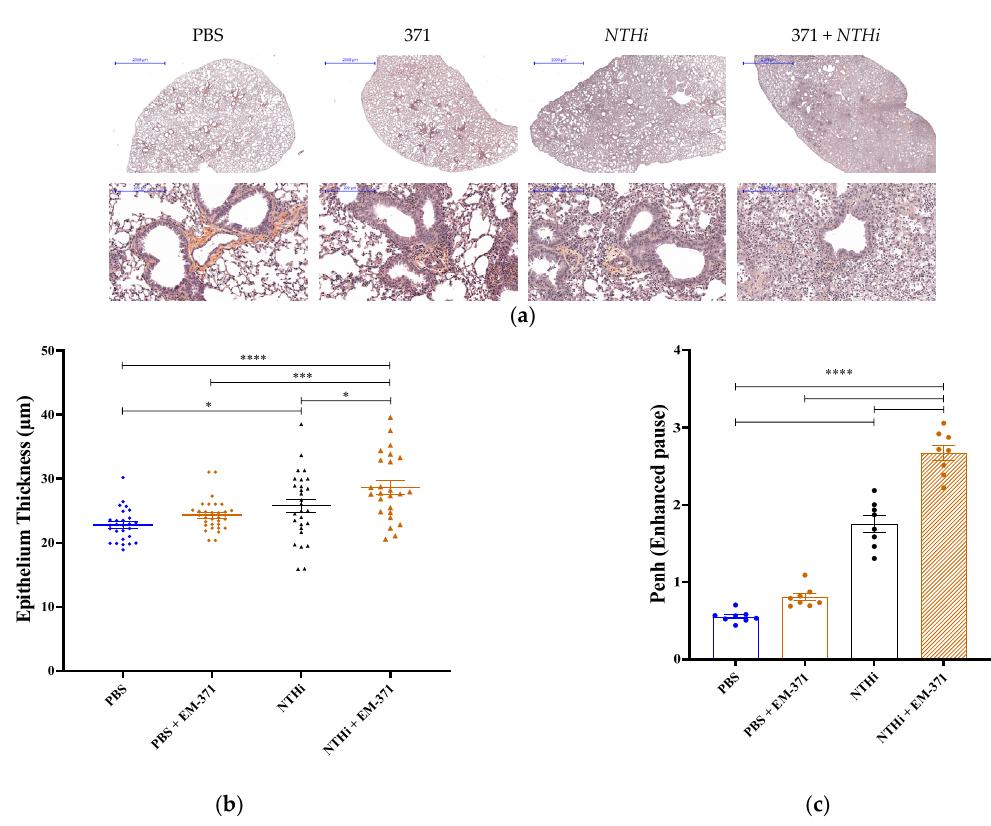
Figure 5. NTHi -challenged mice showed increased levels of inflammatory cell recruitment near the airway and epithelium thickening. ( a ) Lungs were fixed, embedded in paraffin and sectioned at a thickness of 5 µm. Lung sections were stained with hematoxylin–eosin–saffron (HES) and photographed using Case Viewer software. One representative lung section per group is shown. ( b ) Epithelium thickness was measured using Case Viewer software. The plots in the graph correspond to the measurements of four bronchi for at least six mice per group. Four representative bronchi were selected for each mouse and four measurements were performed per bronchus (up, down, left, right side). ( c ) Respiratory distress (Penh) measured by whole-body plethysmography. One-way